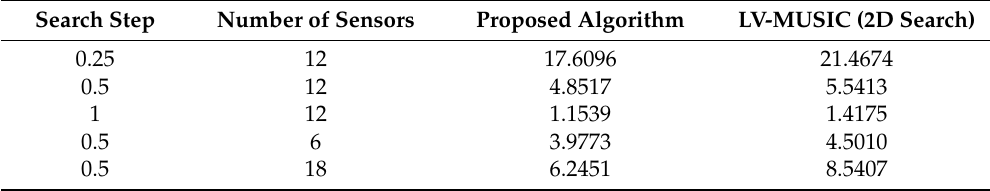
Table 2. Comparison of the average running time (s) with 200 Monte Carlo